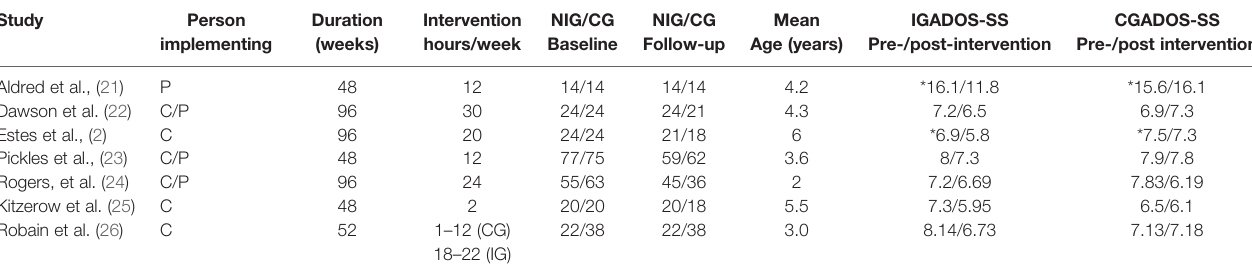
TABLE 7 | Early intervention studies reporting post-treatment changes in ADOS scores. Study Person